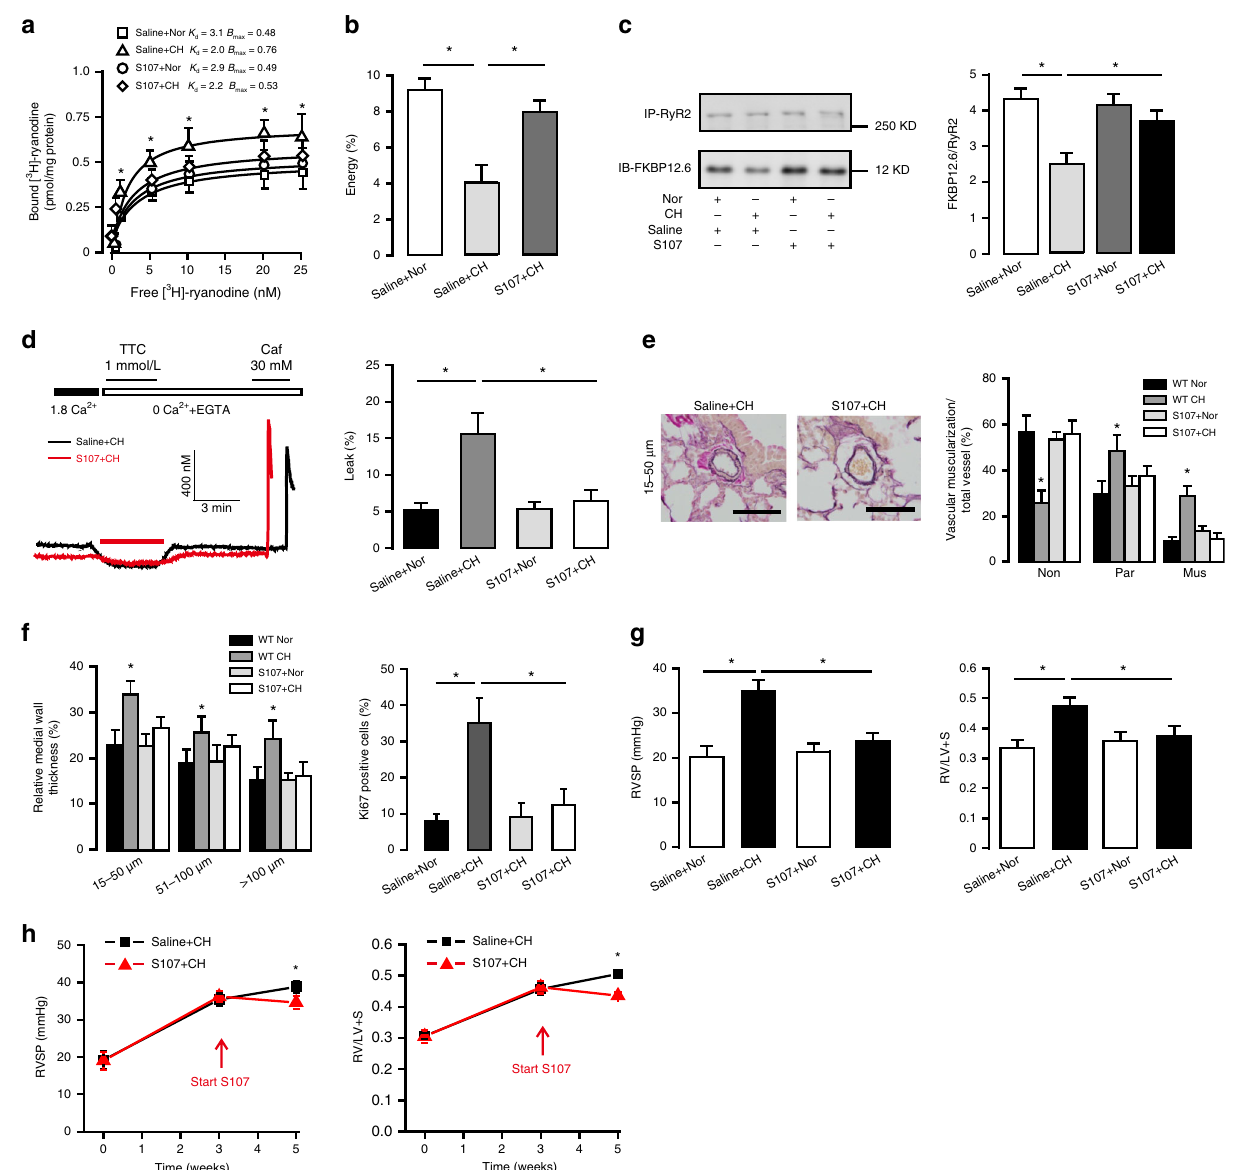
Fig. 5 S107 prevents the development of PH as well as hyperfunctional Ca 2 + signaling. a Determination of RyRs activity by [ 3 H]-ryanodine binding assays in the S107 treating groups ( n = 5 independent studies, 6 mice per study). b The percentage of FRET ef fi ciencies between RyR2/FKBP12.6 pairs ( n = 3 independent studies, 70 cells per study). c Representative immunoblots of RyR2 and FKBP12.6 in S107 treating group showed reduced depletion of FKBP12.6 from RyR2. Bar graph summarizes the association ratio of FKBP12.6 to RyR2 (n = 4 independent studies, 5 mice per study). d Representative [Ca 2 + ] i tracing from PASMC loaded by fura-2/AM switch to 0 Ca 2 + PSS and 1 mmol/L TTC to block RyR2. SR Ca 2 + content is measured by adding 30 mM caffeine. SR Ca 2 + leak ratio is quanti fi ed and normalized to SR Ca 2 + storage ( n = 5 independent studies, 90 cells per study). e Typical lung sections depicting pulmonary arteries in S107 treatment group (bar scale: 50 µ m). Proportion of non-(Non), partially (Par), or fully (Mus) muscularized PAs in total counted PAs ( n = 7 independent studies, 60 vessels per study). f Medial wall thickness of PAs sized 15 – 50, 51 – 100, and over 100 μ m in relation to cross- sectional diameter. PASMC proliferation (Ki-67 staining) in vivo after CH ( n = 7 independent studies, 60 vessels per study). g 3 weeks treatment of S107 (20 mg/kg/d) prevents the elevation of RVSP in hypoxia induced PH and RV hypertrophy ( n = 7 independent studies, 5 mice per study). h S107 treatment can prevent the further progression of RVSP and right ventricular hypertrophy (RV/LV + S) ( n = 5 independent studies, 5 mice per study). Data are expressed as mean ± standard error. (* P < 0.05, using one-way ANOVA